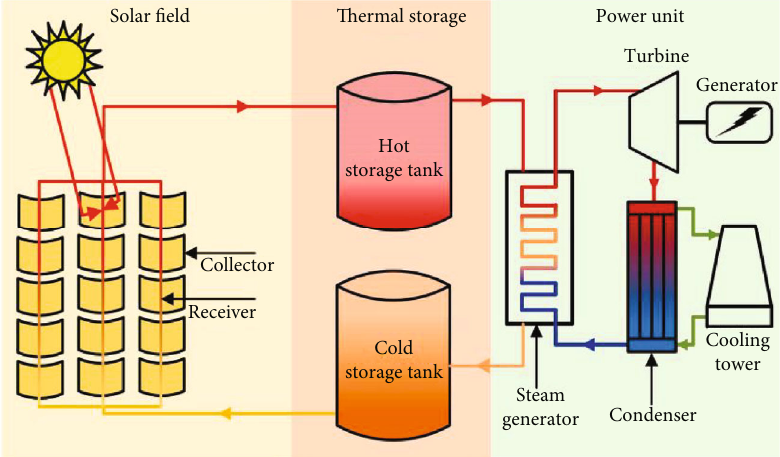
Figure 3: Schematic of the parabolic trough [21].